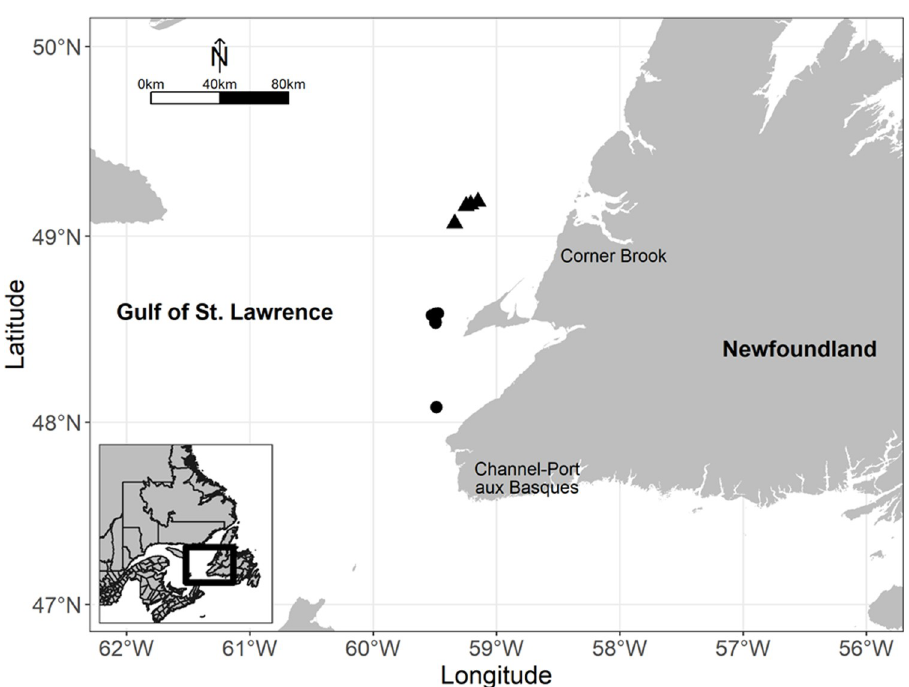
Fig 2. Map of fishing trials in the Gulf of St. Lawrence, Canada. Black points represent locations of shaking codend hauls, black triangles represent locations of T90 codend hauls. Reprinted from GADM under a CC BY license, with permission from [https://gadm.org], original copyright